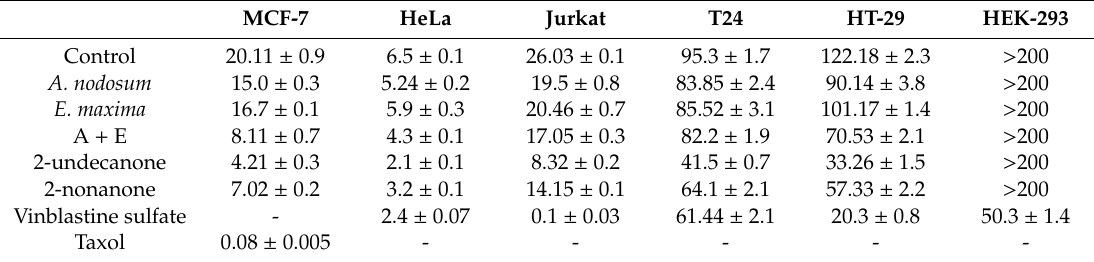
Table 2. In vitro antiproliferative activity, IC 50 (µg mL − 1 ), of R. graveolens EOs as affected by seaweed extracts (SWE) treatments.